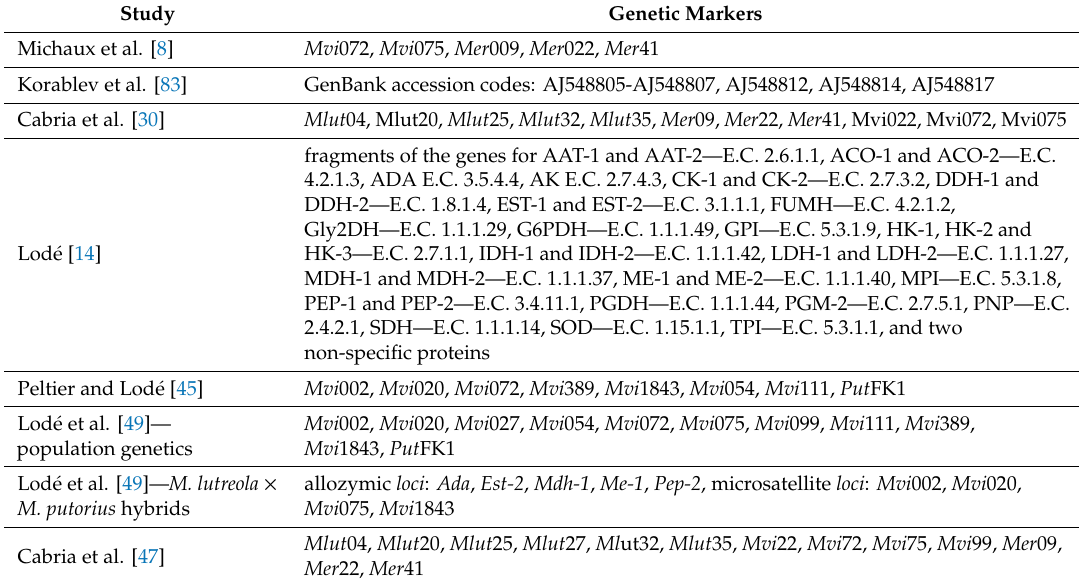
Table 4. Genetic markers used in research on M. lutreola population